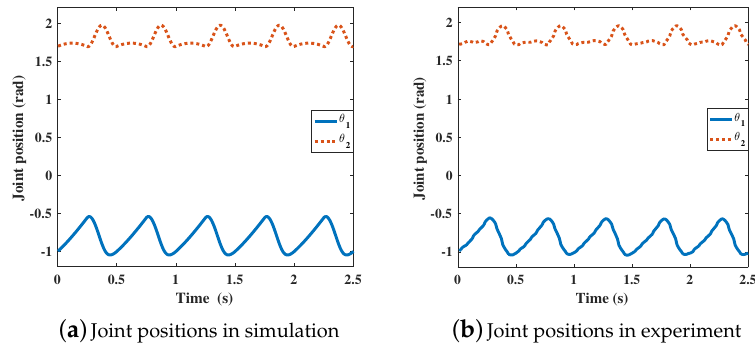
Figure 10. The joint positions of the RF leg.